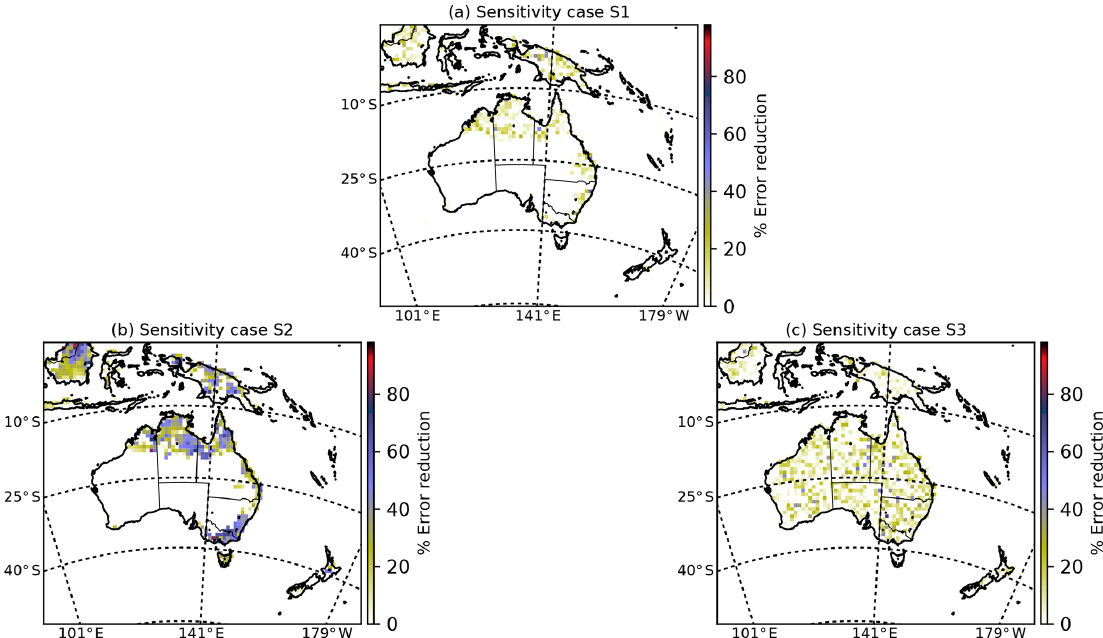
Figure 8. Maps of the percentage of error reduction for the three sensitivity cases. (a) Using only nadir OCO-2 sounding and correlation lengths 50 and 100km. (b) Using “nadir” and “glint” OCO-2 sounding and correlation lengths of 500 and 1000km. (c) Uniform uncertainties over land and ocean, and correlation lengths of 5 and 10km.